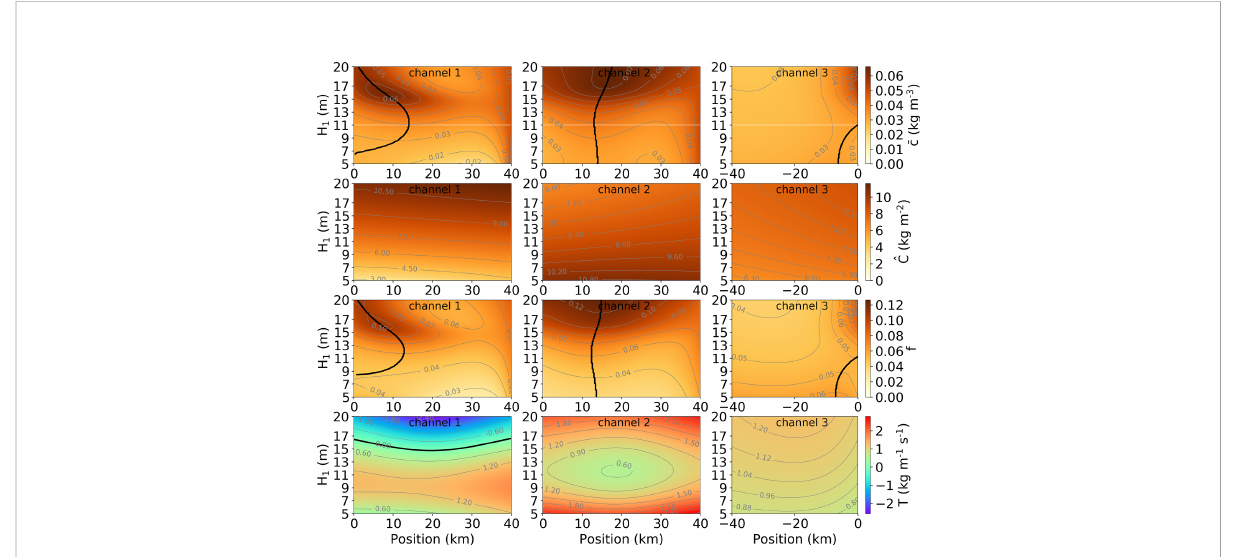
FIGURE 10 Sensitivity of along-channel pro fi les of depth-averaged subtidal concentration ( fi rst row), carrying capacity (second row), availability (third row), and transport capacity p.u. width (fourth row) to the mean water depth of Channel 1. The white line in the fi rst row is where H 1 = 11 m.